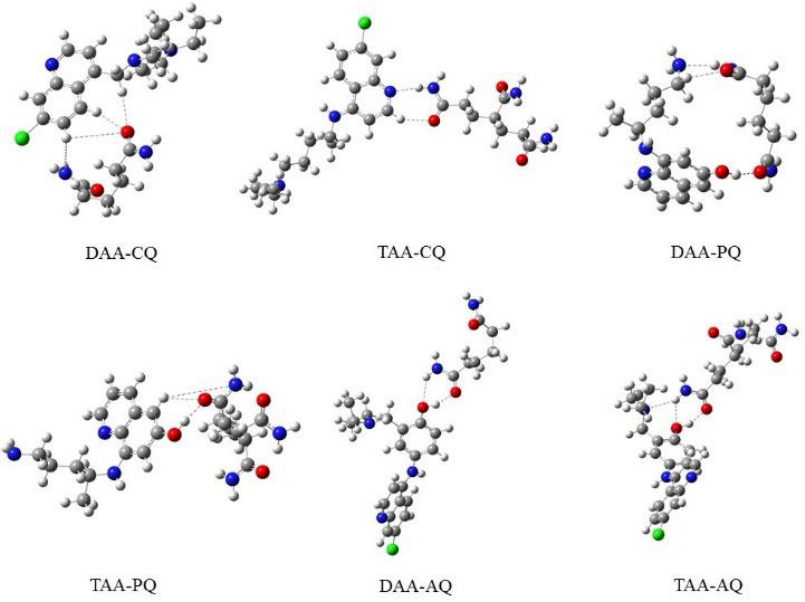
Figure 2. Minimum energy geometry for complexes antimalarial-hydrogel model at the wb97xd/6-31++G(d,p) theory level. Dashed line shows the short-range interactions.